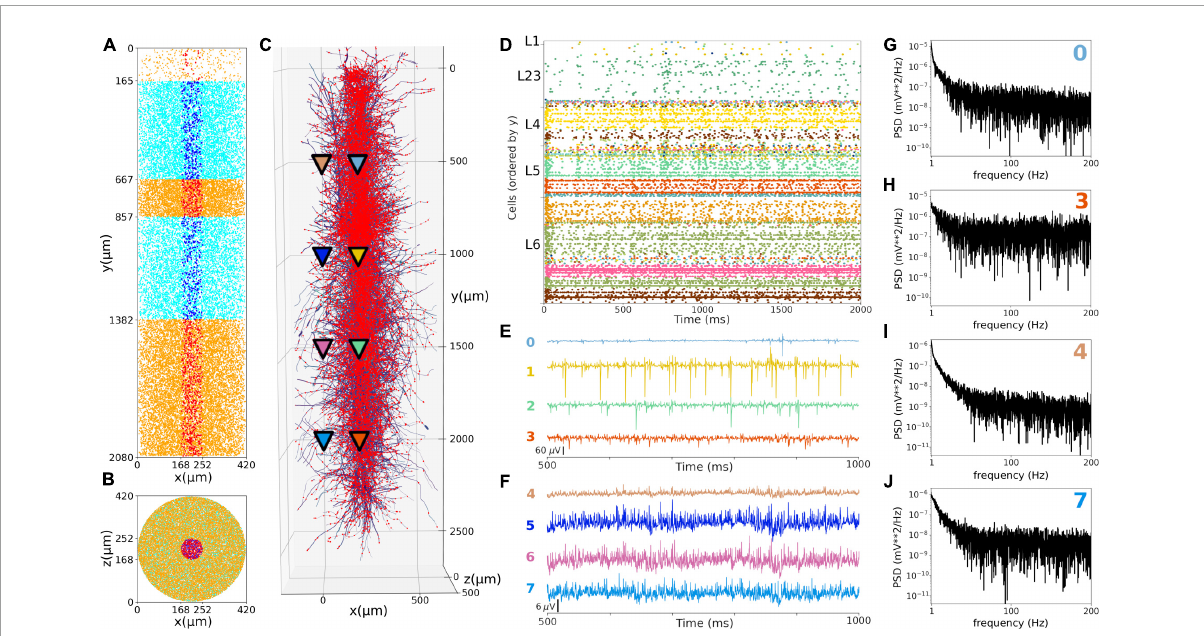
FIGURE9 Local field potentials (LFPs) recorded from the in vivo -like S1 circuit. (A,B) Lateral and top-down 2D representation of the location of 1,376 morphological cells within a cylinder with 2,082 µ m height and 84 µ m radius. Morphologically-detailed neurons are shown in red (L1, L4, and L6) and blue (L23 and L5); whereas the 29,970 simplified cells (spike generators) are shown in orange (L1, L4, and L6) and cyan (L23 and L5) circles. (C) 3D representation of the morphologically-detailed neurons with the location of all synapses (red dots), and the location of the 8 LFP recording electrodes at 4 different depths and 2 radial distances (color triangles). (D) Spiking raster plot of the morphologically-detailed neurons used to calculate the LFP. (E) LFP signals recorded at the 4 electrodes in the center of the cylinder (colors correspond to triangles in panel C ). Electrodes numbered 0, 1, 2, and 3 correspond with cortical depths (y) 500, 1,000, 1,500, and 2,000 µ m, respectively. (F) Same as E, but for the LFPs recorded at a radial distance of 297 µ m; electrodes 4–7. (G–J) Power spectral densities (PSDs) for electrodes 0, 3, 4, and 7 calculated over a 10-s simulation (initial transient period was not included). PSDs exhibit an inverse relationship between power and